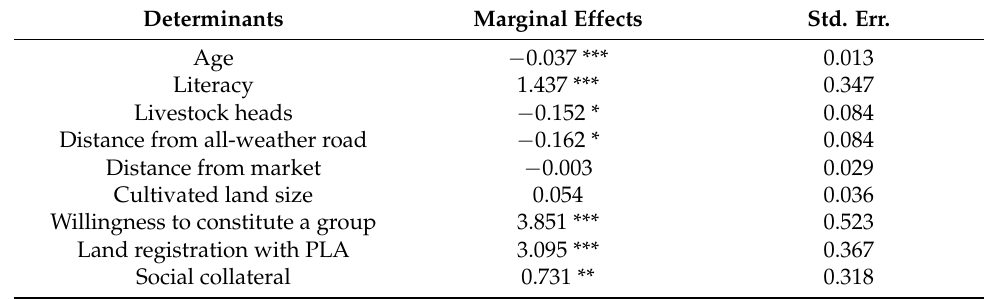
Table 3. Determinants of interest-free agriculture credit participation in rural Punjab.